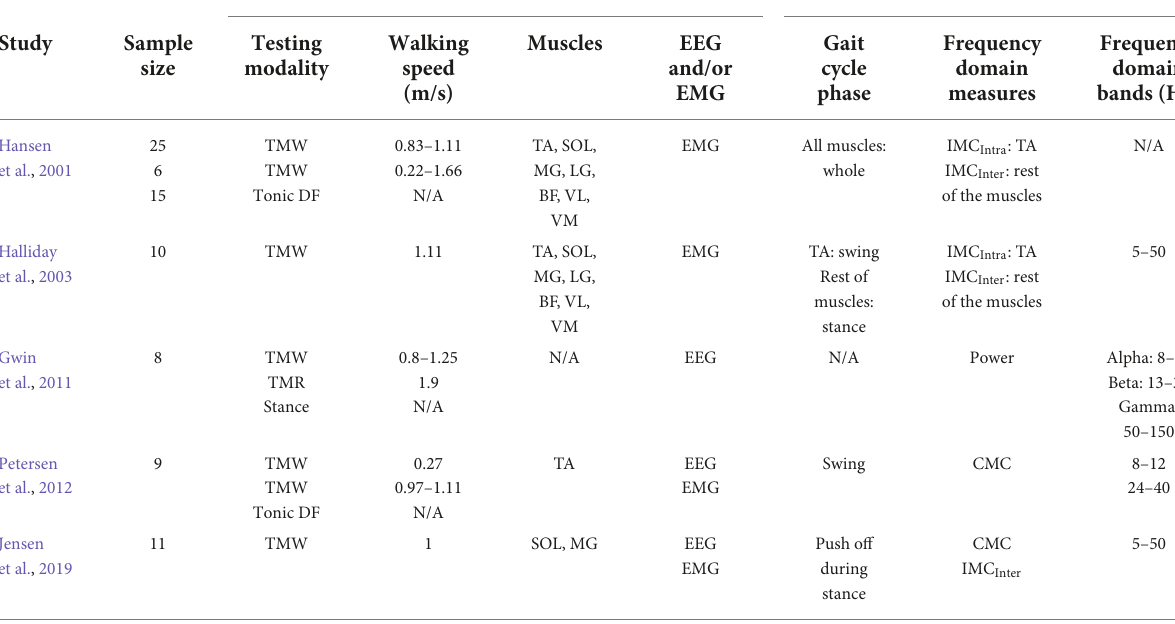
TABLE 1 Characteristics of studies that examined oscillations during neurotypical